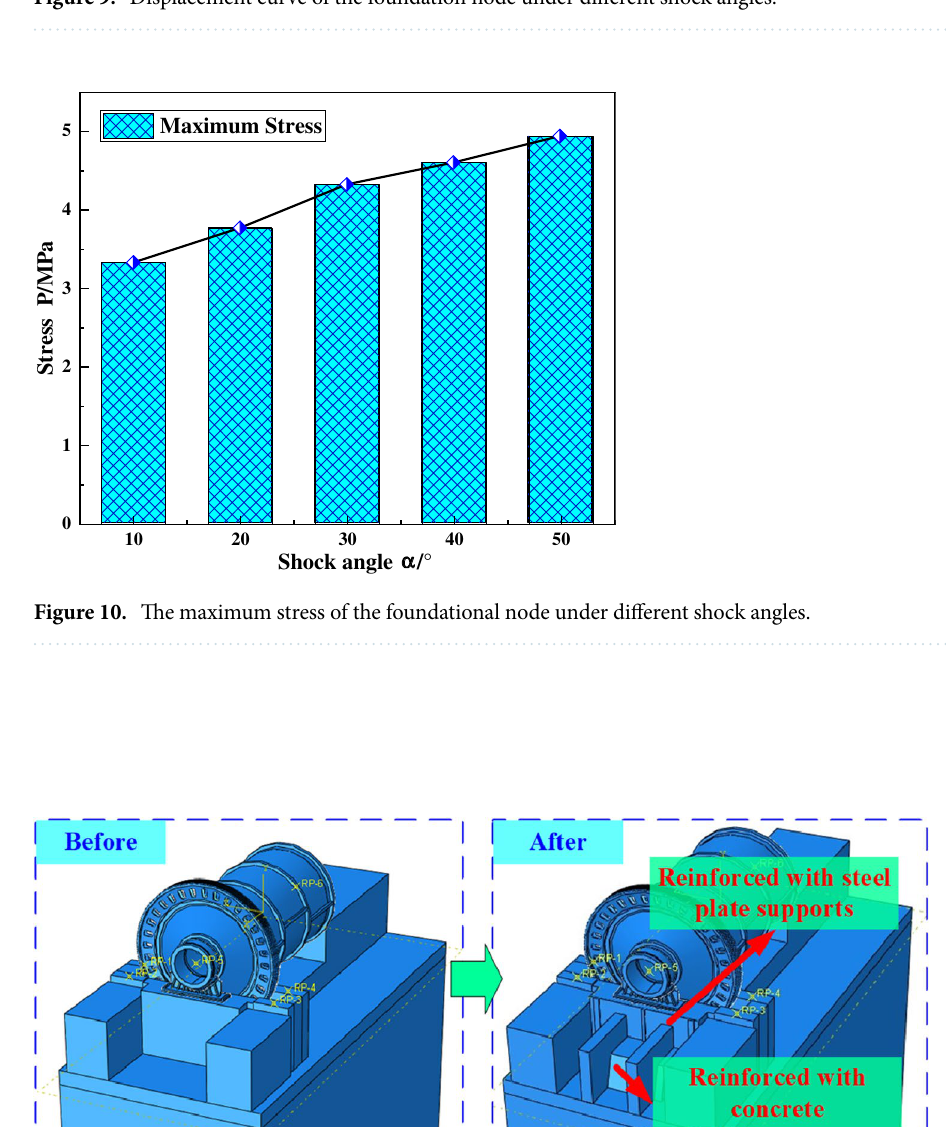
Figure 9. Displacement curve of the foundation node under different shock angles.